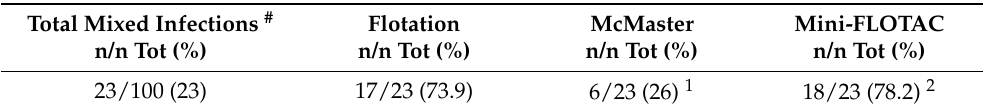
Table 4. Number of canine samples in which all the parasites involved in mixed infections have been detected using flotation, McMaster, and Mini-FLOTAC,